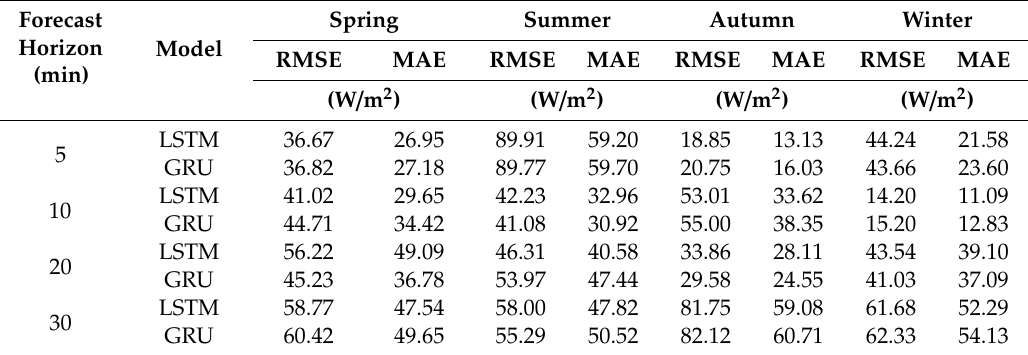
Table 6. RMSE of LSTM and gated recurrent unit (GRU) for very short-term forecasting. Forecast